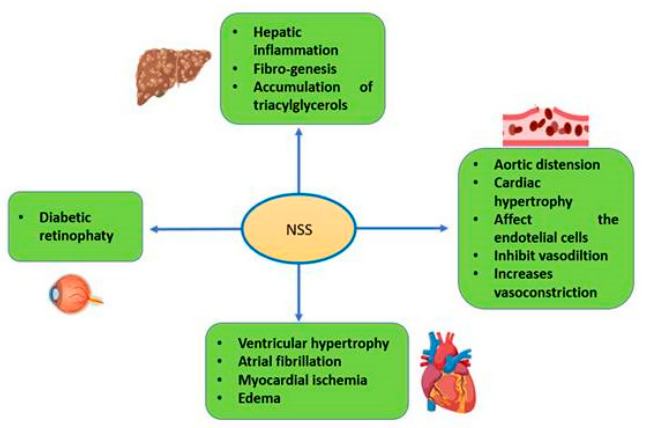
Figure 4. Relation of NSS with some metabolic disorders. Abbreviations: NSS = nitrosative stress. In spontaneously hypertensive rats, endothelial dysfunction is associated with an increase in uncoupled eNOS and with the generation of ONOO − . In other rodent models of hypertension, NAD(P)H oxidase and low levels of BH 4 contribute to OS, which uncouple eNOS and cause the increase in the blood pressure [136].